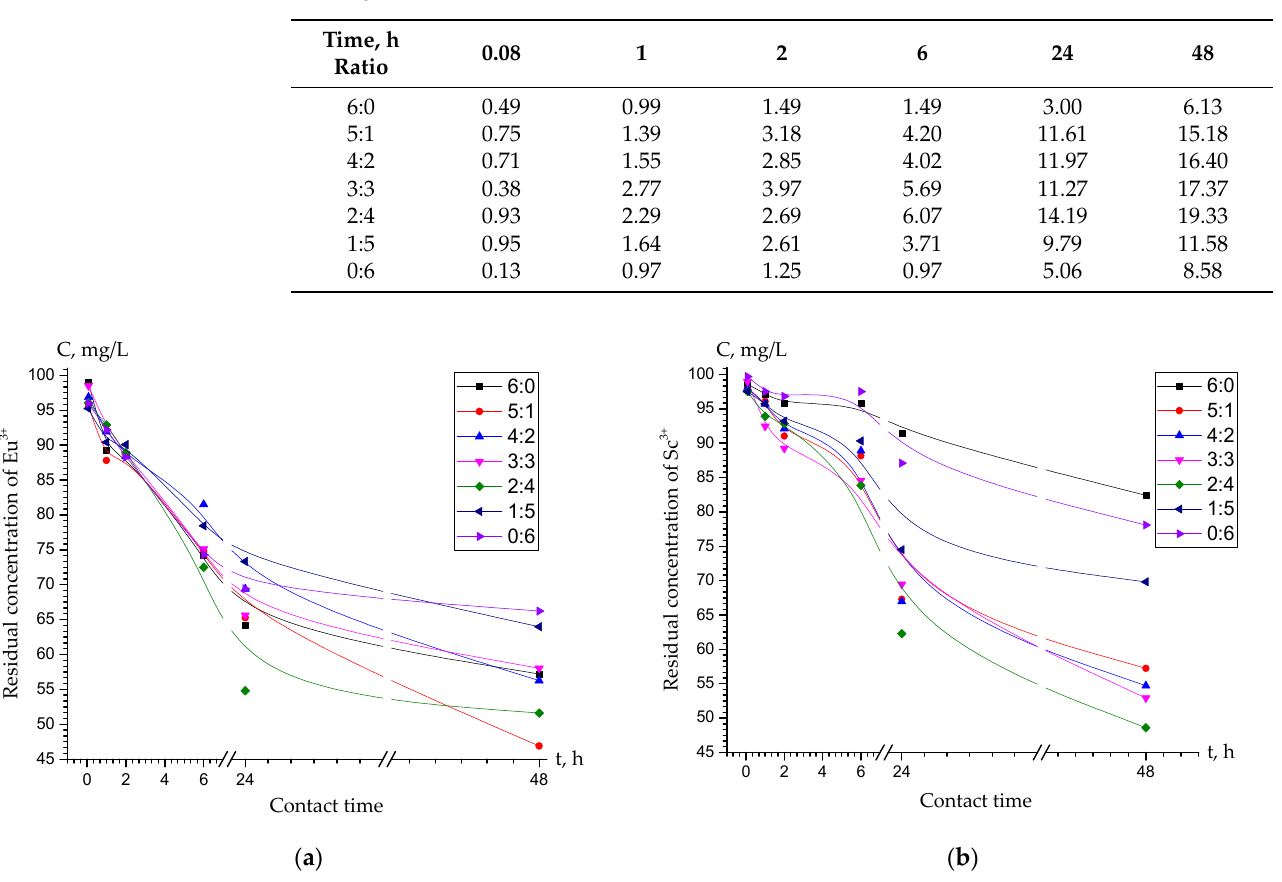
Table 2. The polymer chain binding degree of the scandium ions at different ratios of the ion exchangers ( θ , %).